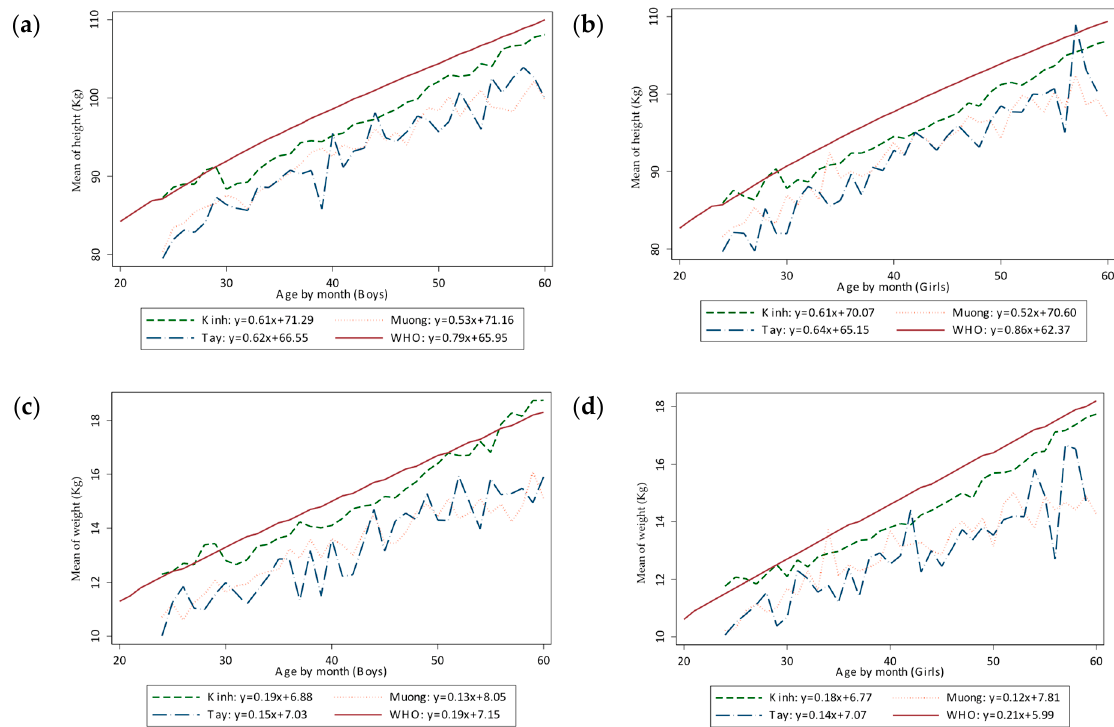
Figure 2. The development of height and weight by age in different ethnicities in comparison with WHO 2006 reference population. ( a ) height in boys; ( b ) height in girls; ( c ) weight in boys; ( d ) weight in girls.